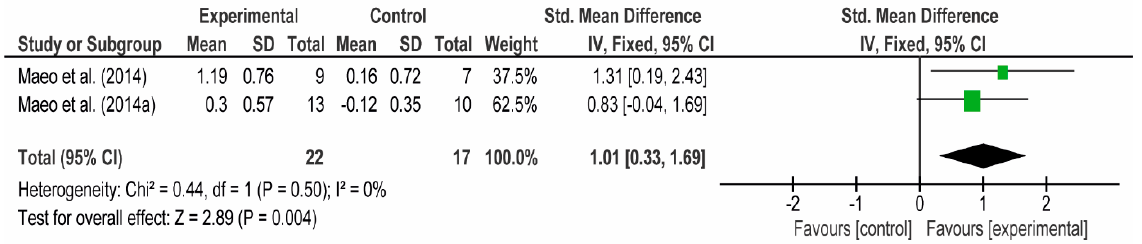
Figure 23. The effect size of isometric maximal voluntary co-contraction training on the elbow flexors